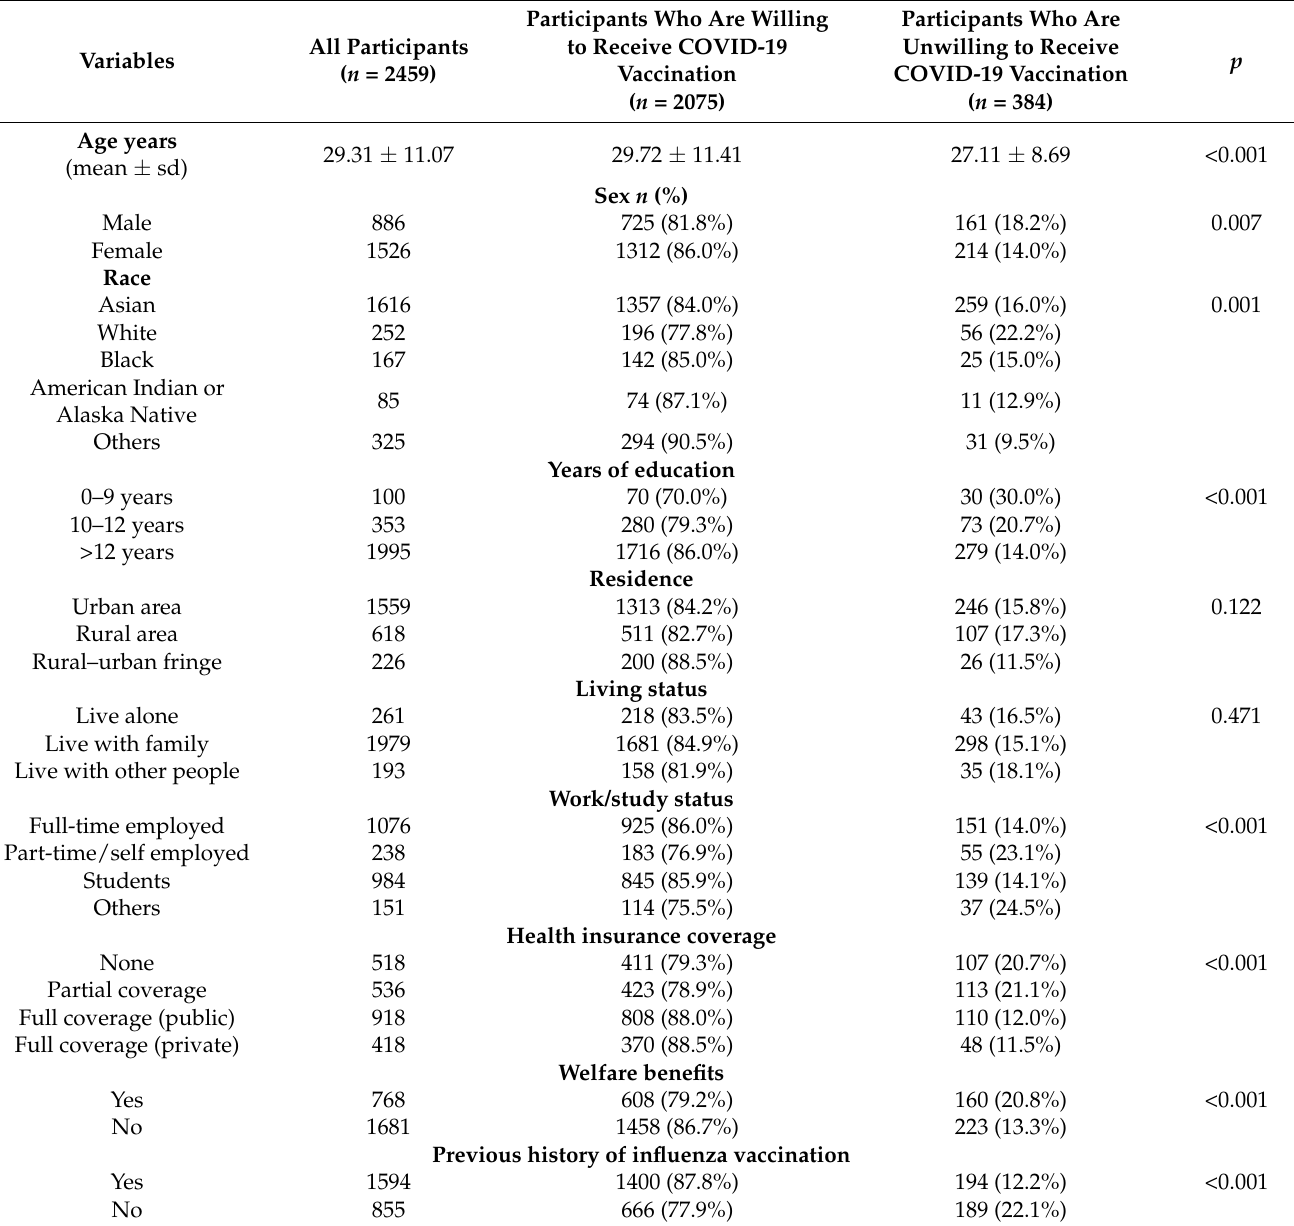
Table 1. Socio-demographic characteristics of the